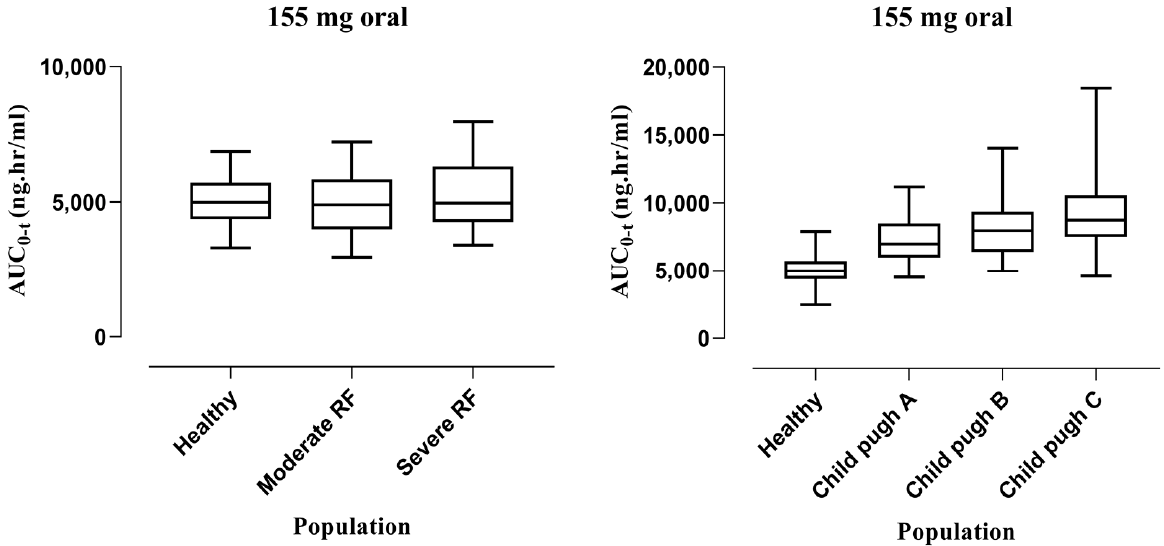
Figure 5. Box plots showing median with 5th–95th percentile after oral administration in liver cirrhosis and CKD.